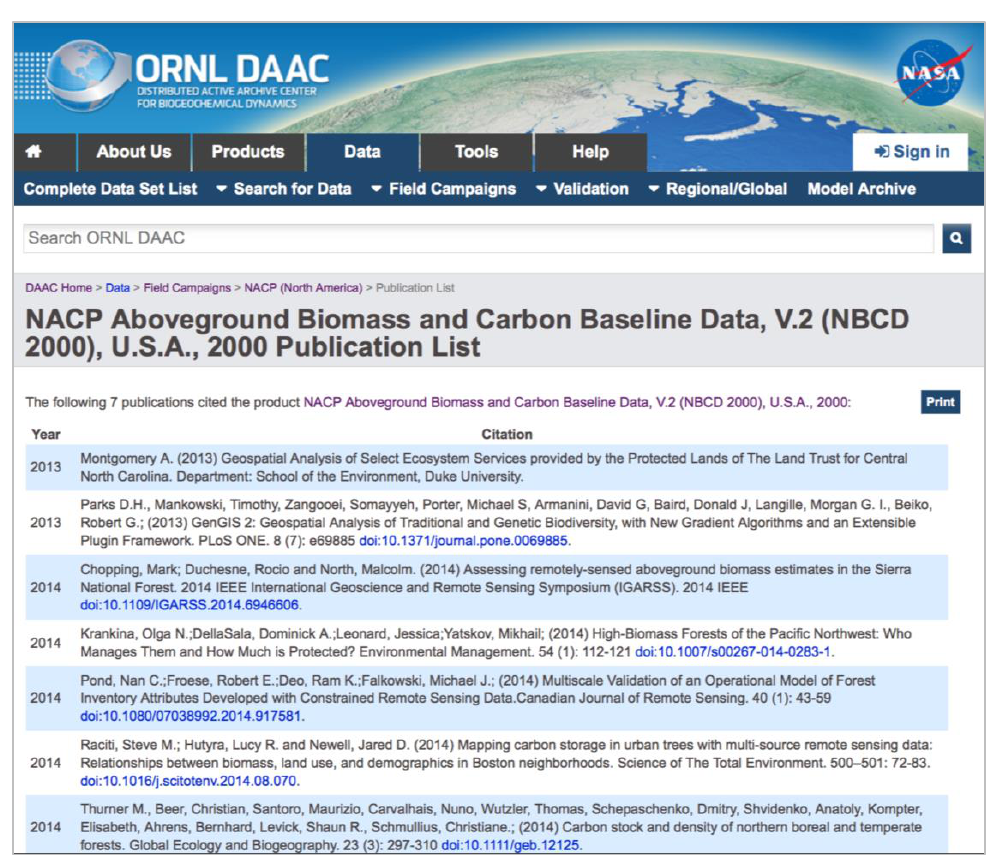
Figure 9. ORNL DAAC website showing publications for a particular data set.